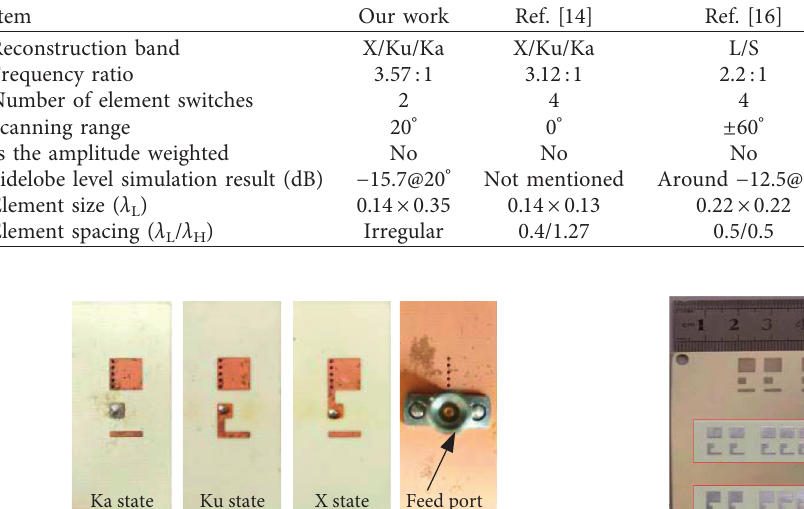
Table 2: Comparison of the FRAA with other multiband/switchable-band antenna arrays.